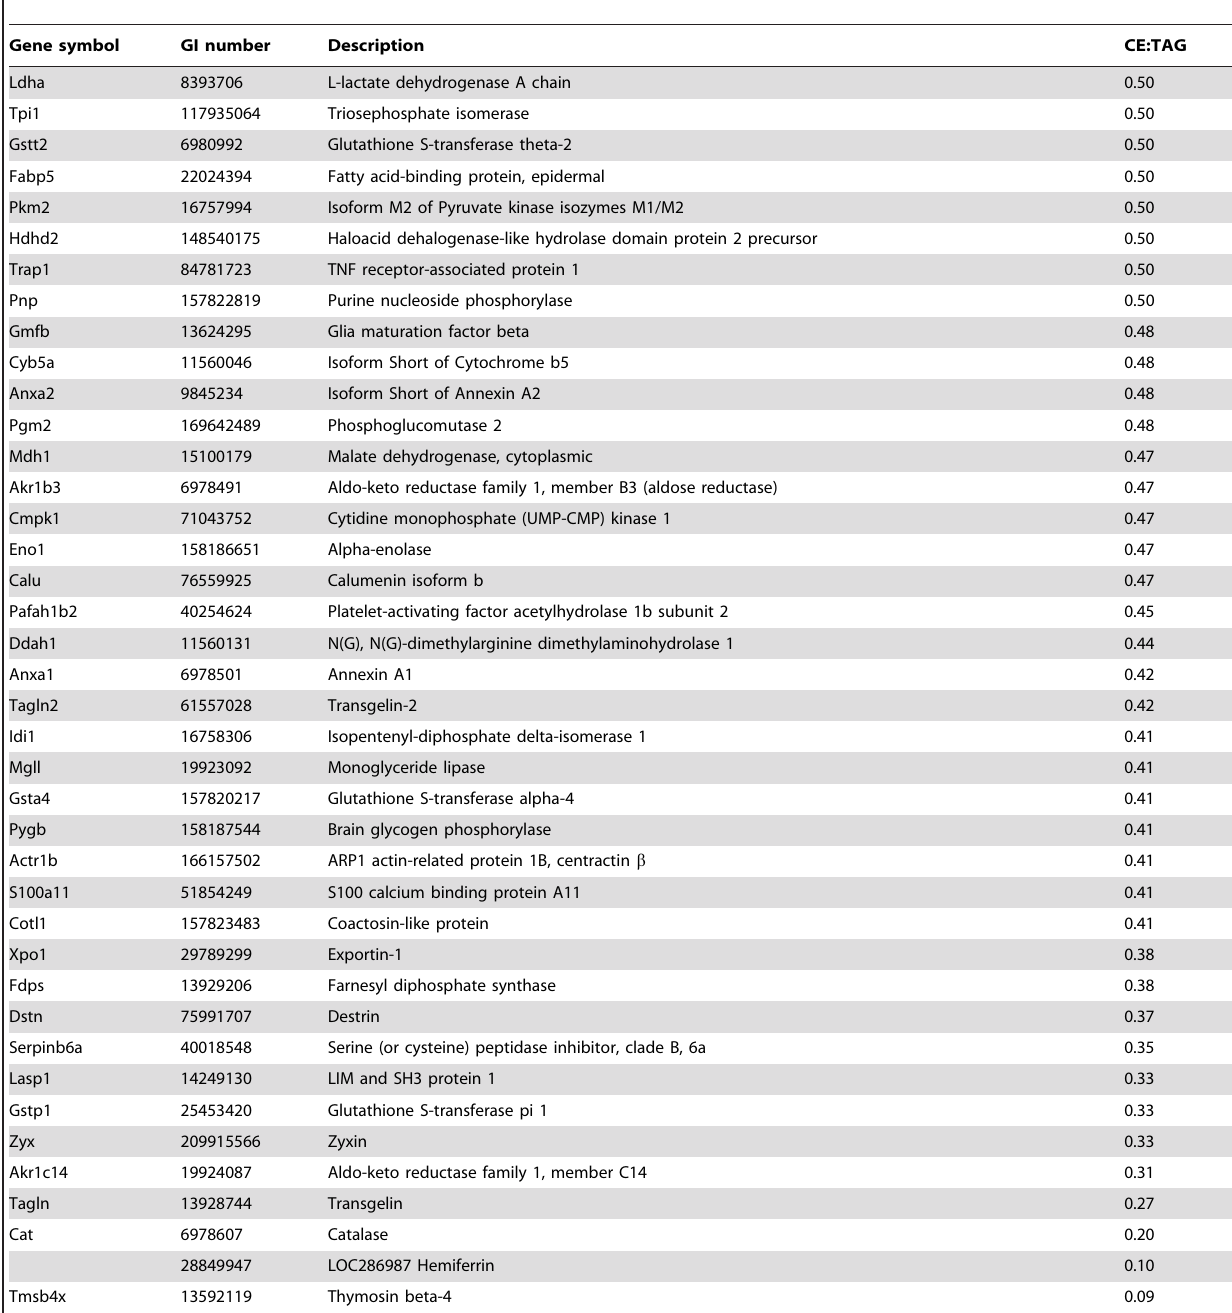
Table 2. List of proteins found in greater abundance in TAG-enriched LDs versus CE-enriched LDs by TMT.